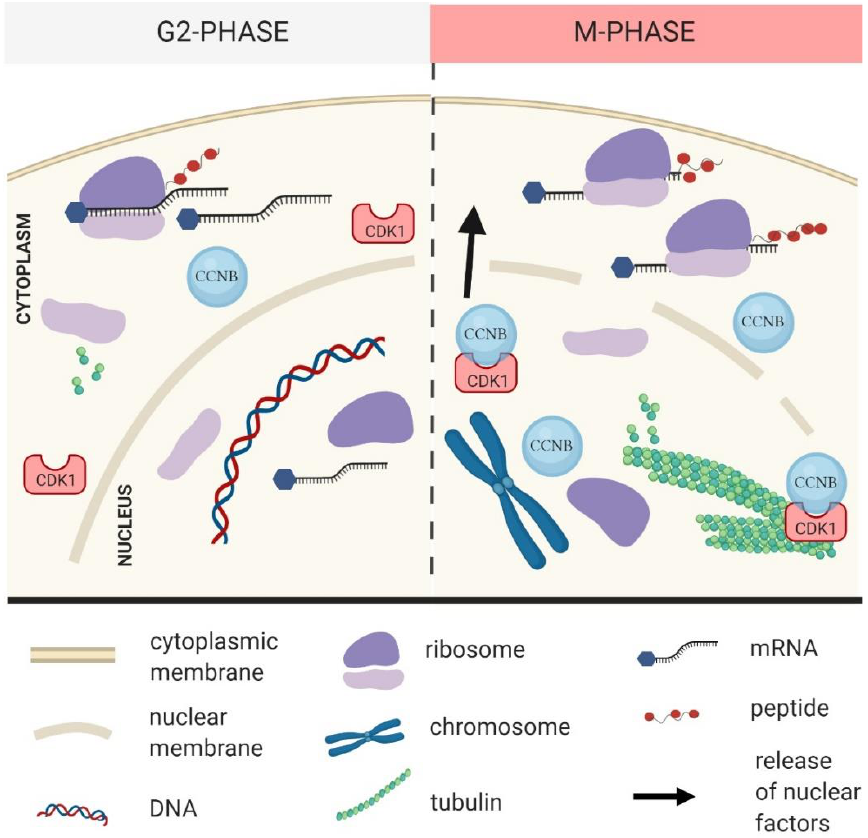
Figure 2. Activated cyclin dependent kinase 1 (CDK1) supports mRNA translation during the M-phase. During the G2-phase, inactive CDK1 with minimal amount of regulatory cyclin B protein (CCNB) is present. Prior to nuclear envelope breakdown (NEBD) CCNB accumulates in the nucleus and binds to CDK1 resulting in an increase of CDK1 activity which leads to NEBD and localization of the complex at the newly forming spindle area. Post NEBD, active CDK1 influences translational reprograming which contributes to successful M-phase progression.